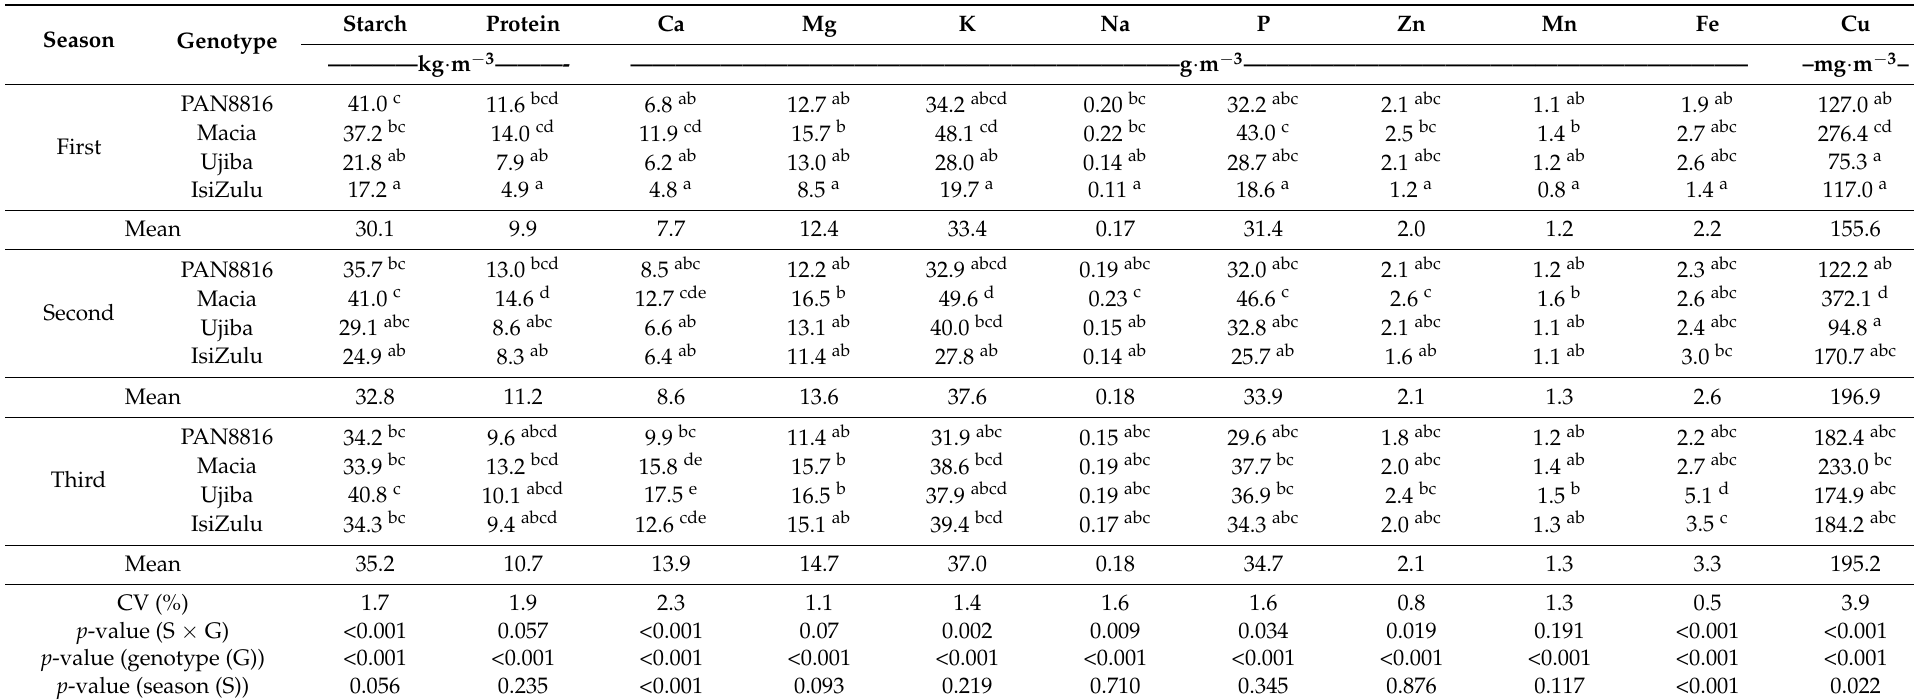
Table 5. Nutritional water productivity of selected sorghum genotypes at different planting